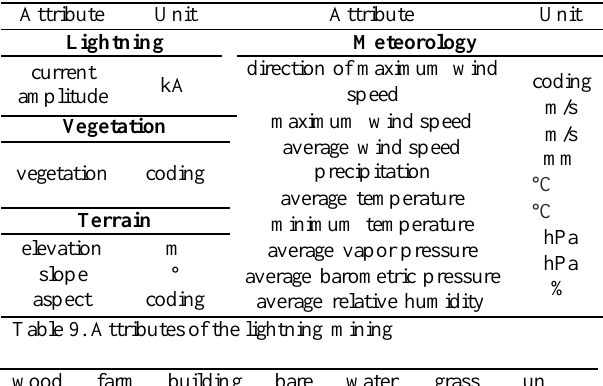
Table 9. Attributes of the lightning mining